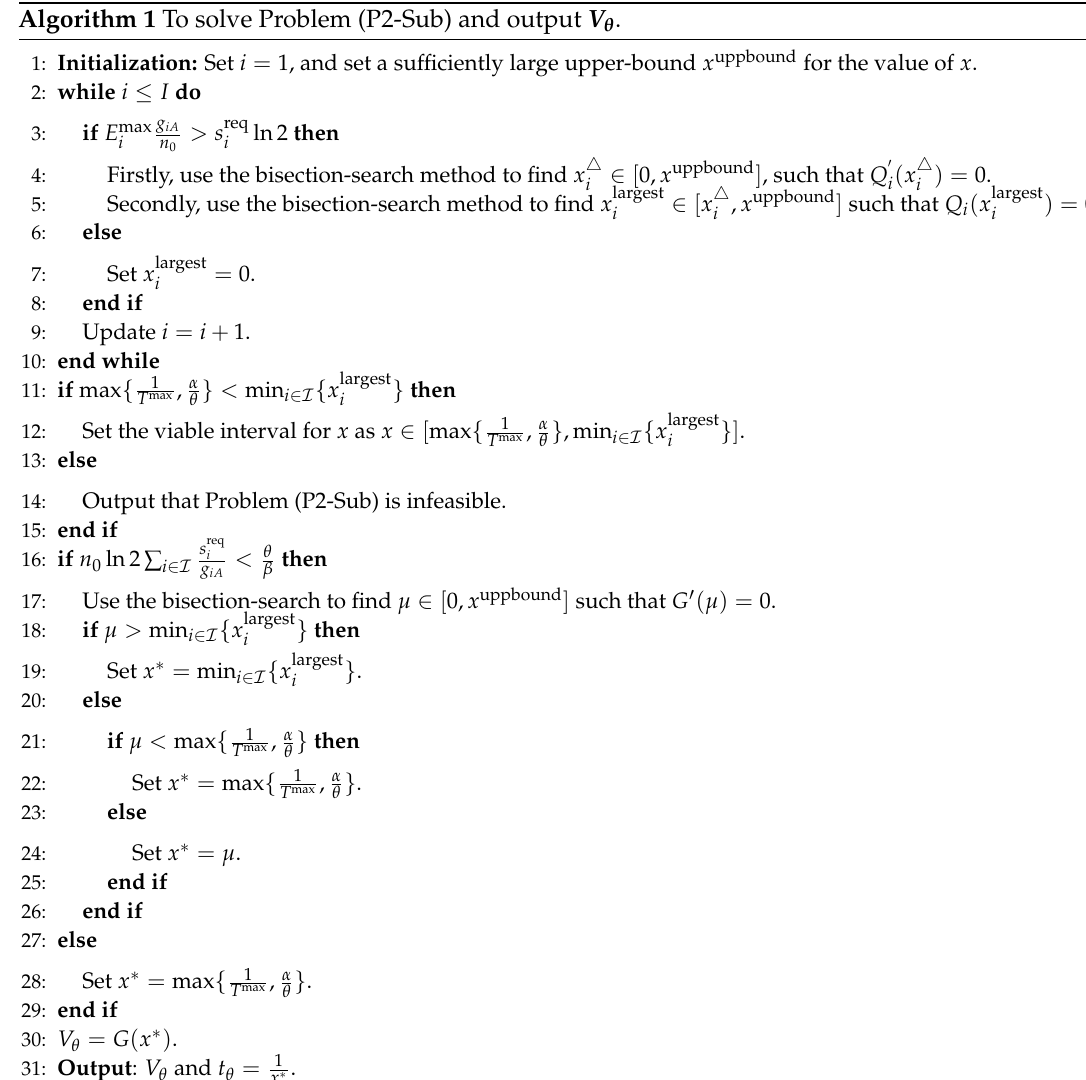
Algorithm 1 To solve Problem (P2-Sub) and output V θ